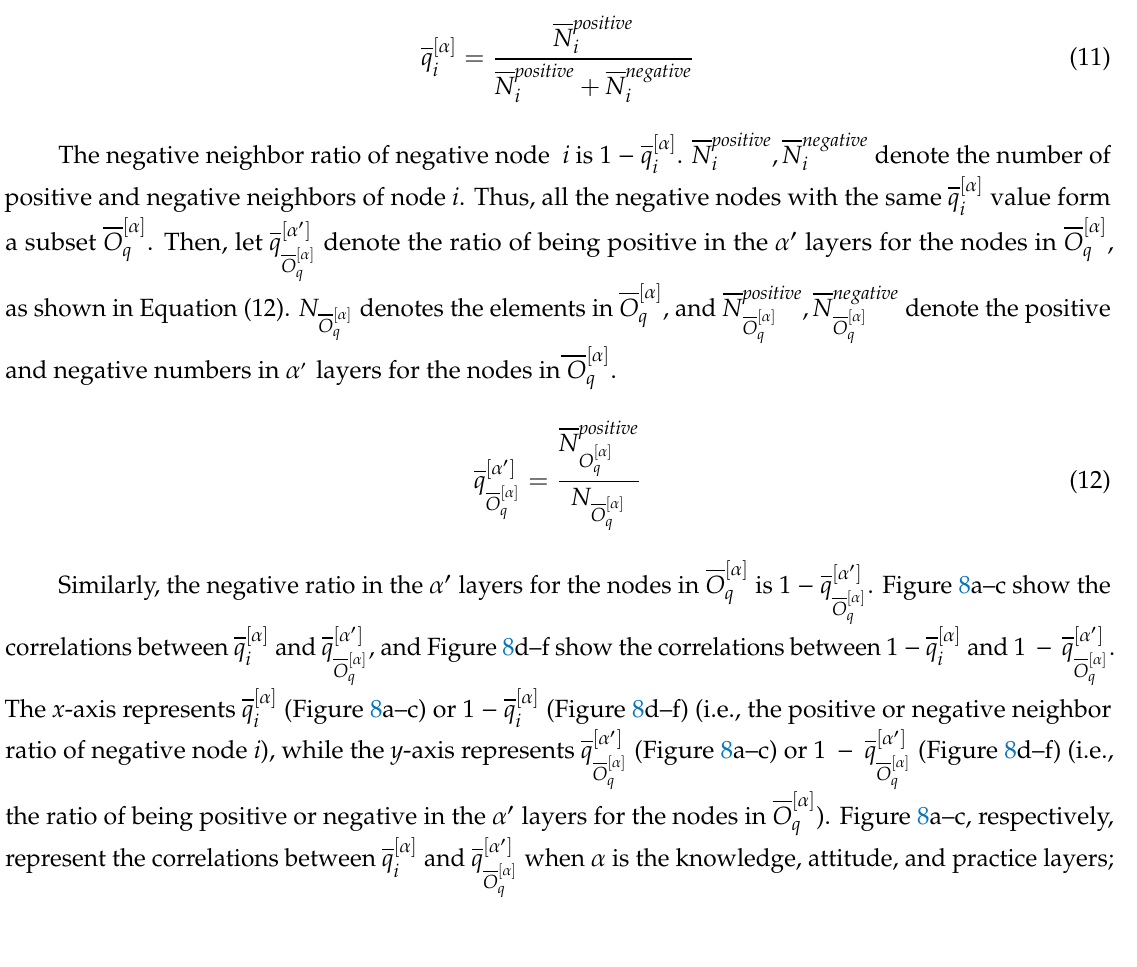
(Figure 8d–f) (i.e., the positive or negative